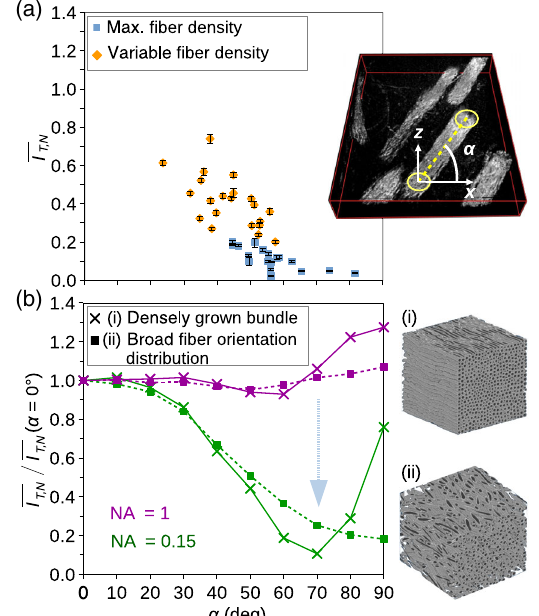
FIG. 3. Transmittance of inclined fiber bundles. (a) Mean normalized transmittance values I plotted against the nerve T;N fiber inclination angles α determined, respectively, from 3D-PLI and TPFM measurements of nerve fiber bundles in a mouse brain section (see Fig. S2 in Supplemental Material [55]). The values in blue belong to regions with similar (maximum) fiber density, and the values in orange belong to regions with variable fiber density in which the transmittance might be overestimated. The error bars indicate the standard error of the mean for the evaluated trans- mittance values. (b) Simulated transmittance curves (mean trans- mittance I vs inclination α ) for a bundle of densely grown T;N fibers (i) and a bundle with broad fiber orientation distribution (ii) for NA ¼ 1 (purple curves) and NA ¼ 0 . 15 (green curves). The transmittance curves are normalized by the mean transmittance values of the horizontal bundles, respectively. The simulations are performed with the parameters specified in Appendix F, using normally incident light with 550 nm wavelength. Both exper- imental and simulated data show that the transmittance decreases with an increasing fiber inclination (for NA ¼ 0 . 15